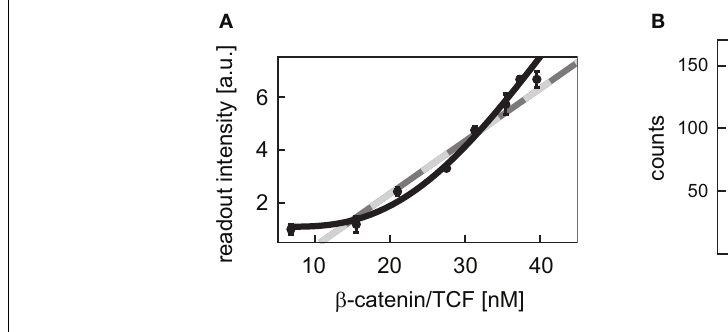
Michaelis–Menten activation lie on top of each other. (B) The distributions of the fitted Hill coefficients are shown for the four reporter constructs. Only those Hill coefficients of fits are taken into account, whose log-likelihood function value deviates at most 20% from the log-likelihood function value of the best fit.The constructs with 3, 8, transiently transfected 12TBEs, and stable integrated 12TBEs are color-coded in black, dark gray, gray, and light gray bars, respectively.